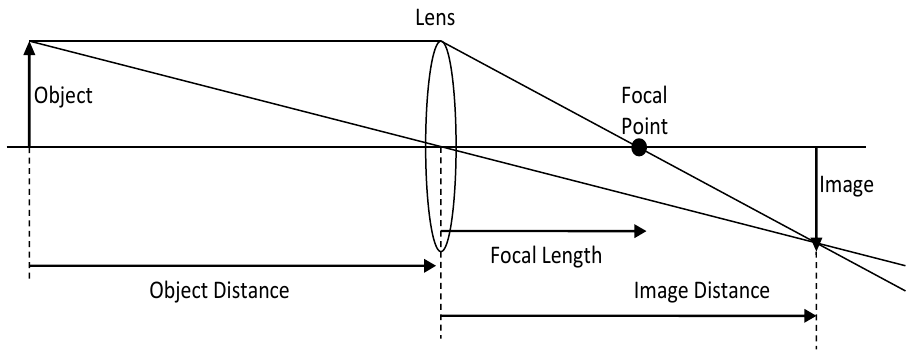
Figure 3. Lens collects the light from the object to create an image. Table 1. The percentages of pixels in images used for model training and validation.